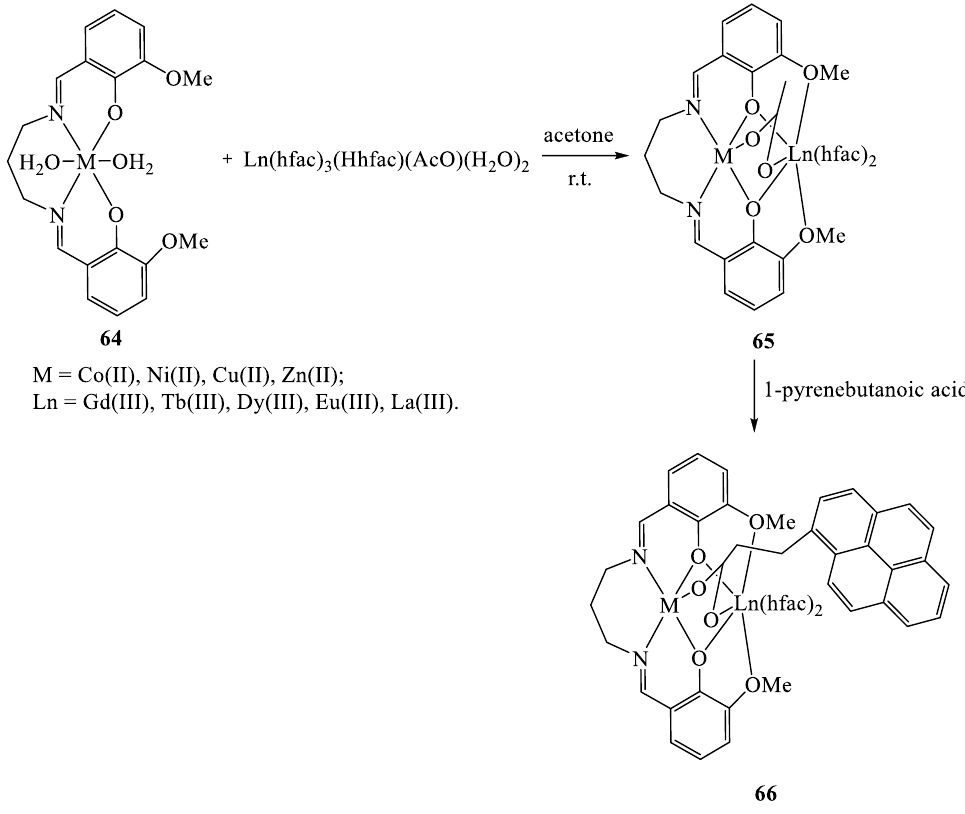
Scheme 27. Synthesis of heterometallic 3d-4f binuclear complexes 65–66